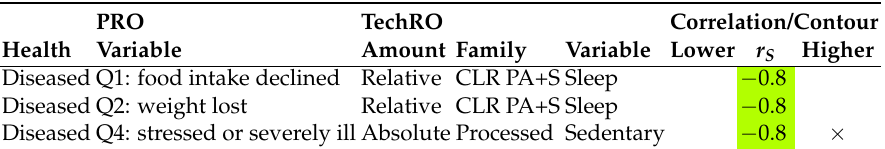
Table 11. Summary of found strong and significant Spearman rank correlations ( r S PROs of nutrition (SelfMNA scale) and TechROs (Fitbit wearable).